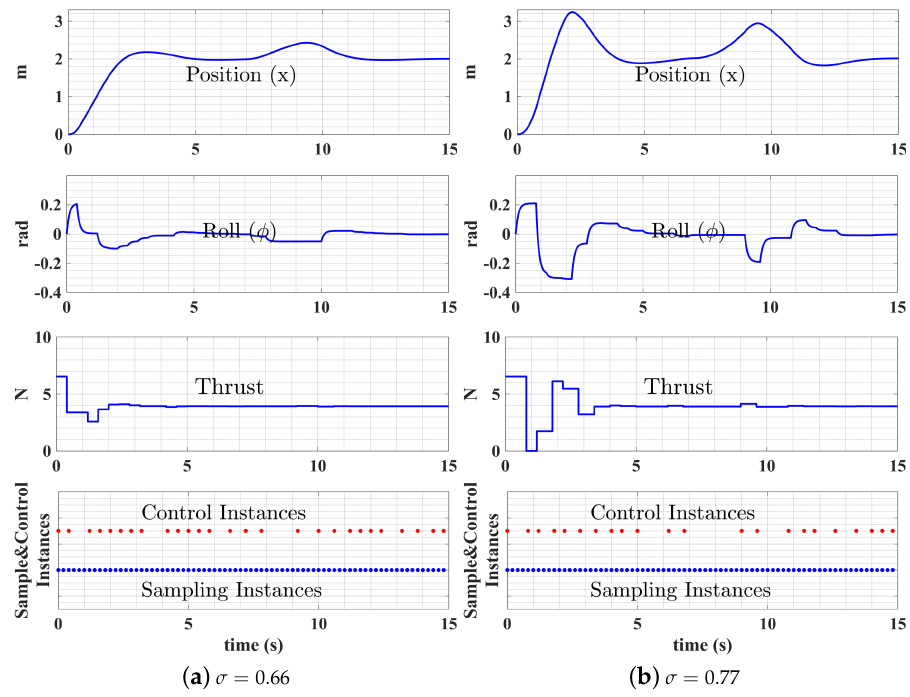
Figure 7. Event-triggered control performances with different σ